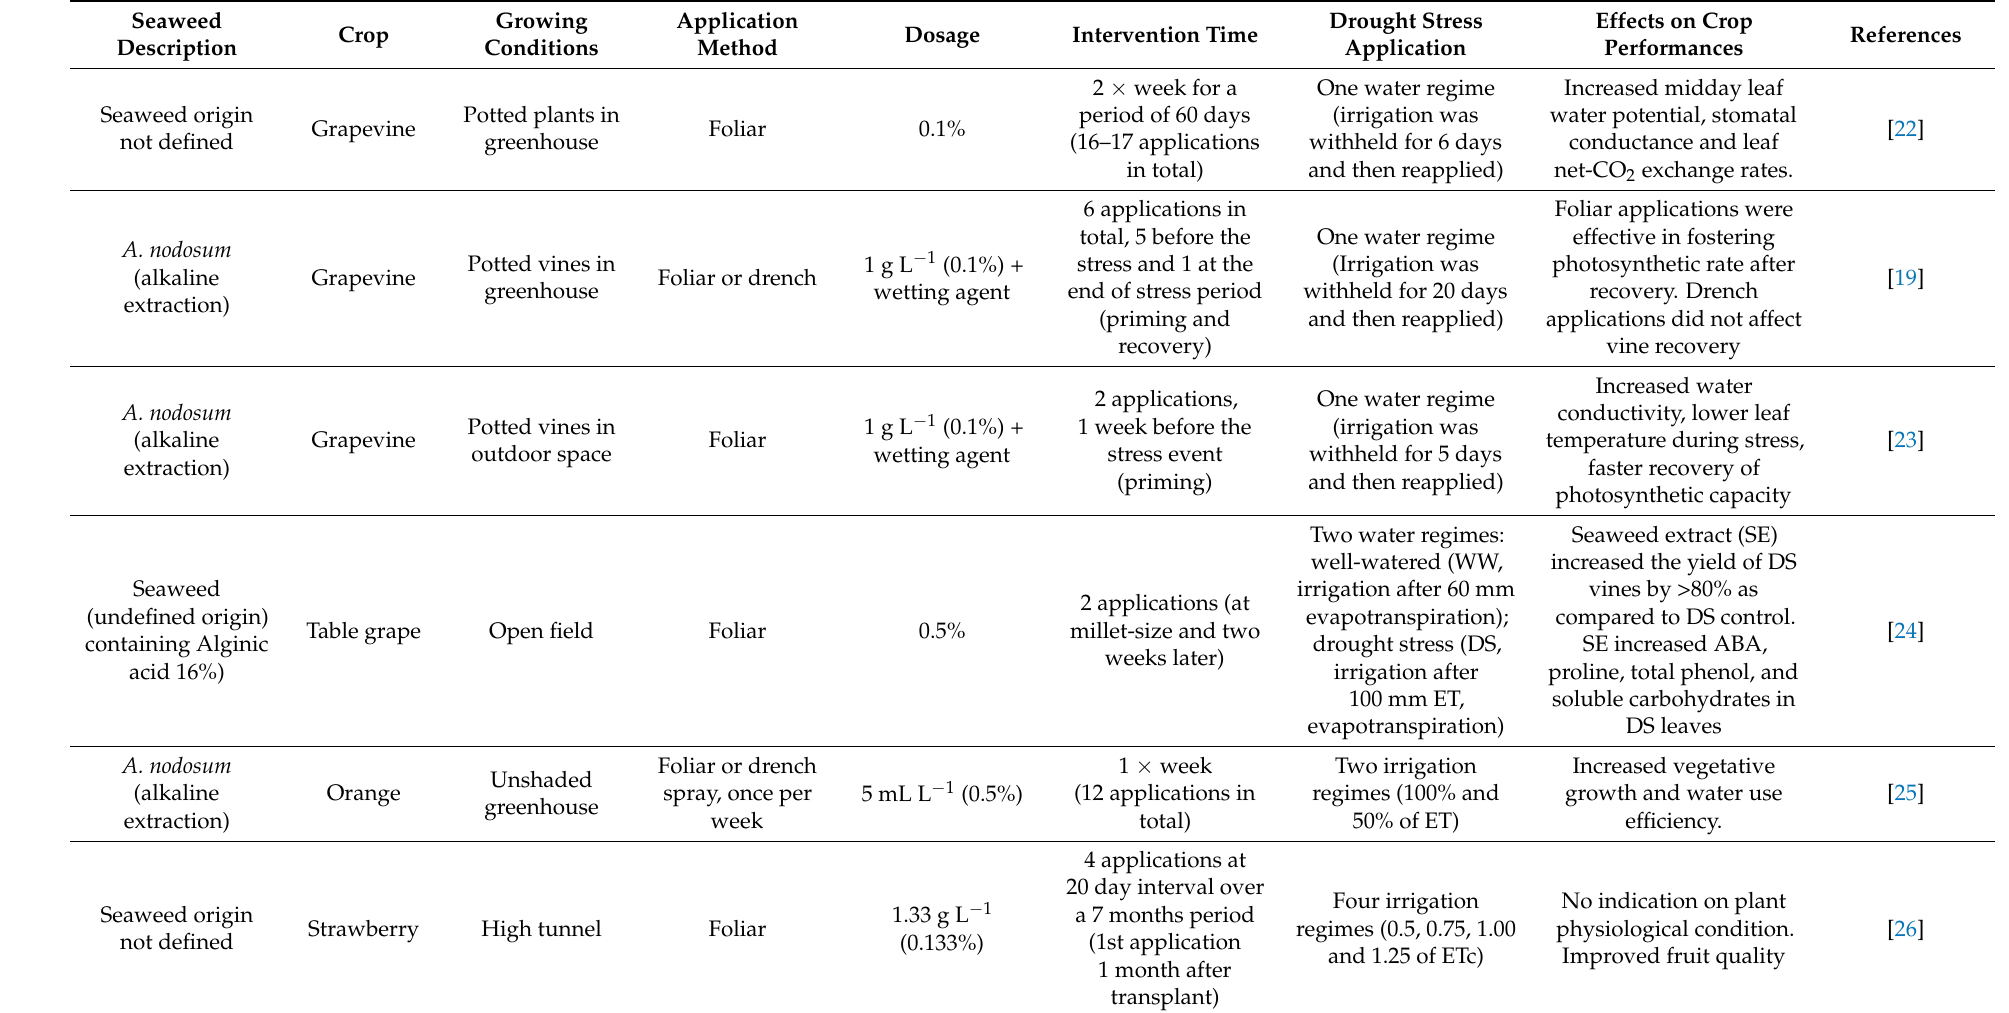
Table 1. Seaweed application methods to increase tolerance toward